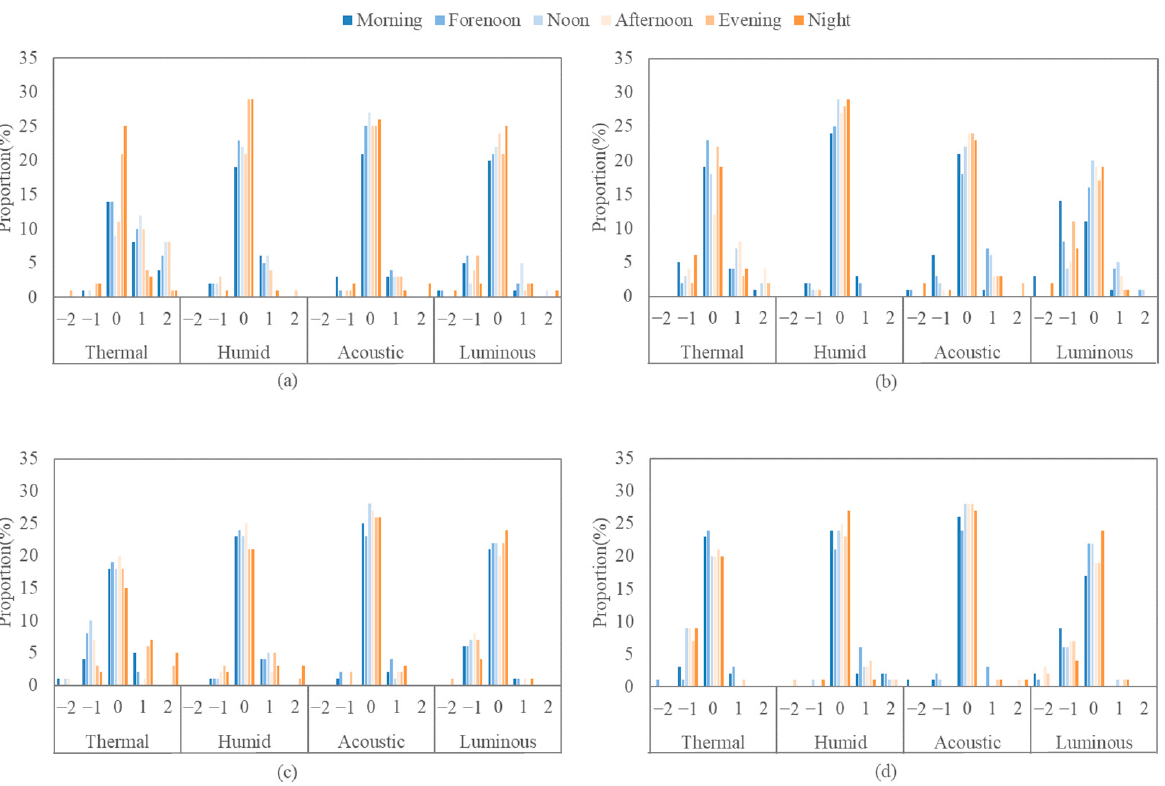
Figure 11. Environmental sensation vote in different periods on ( a ) sunny, ( b ) cloudy, ( c ) overcast, and ( d ) rainy days.